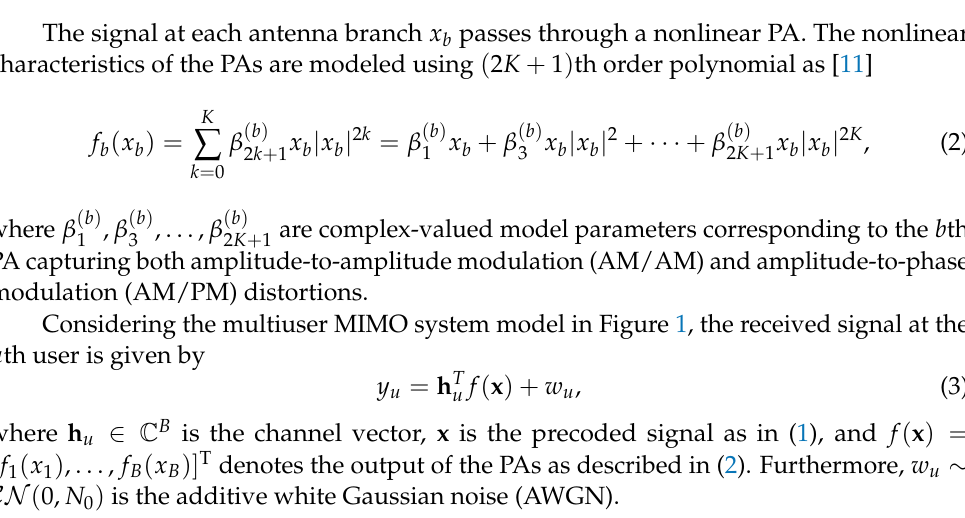
Figure 1. System model: multiuser MIMO downlink with single-antenna UEs. The base station is equipped with B transmit antennas serving U UEs via spatial multiplexing. Each transmit antenna is equipped with a PA whose nonlinearity characteristics and power consumption are modeled as (2) and (20),